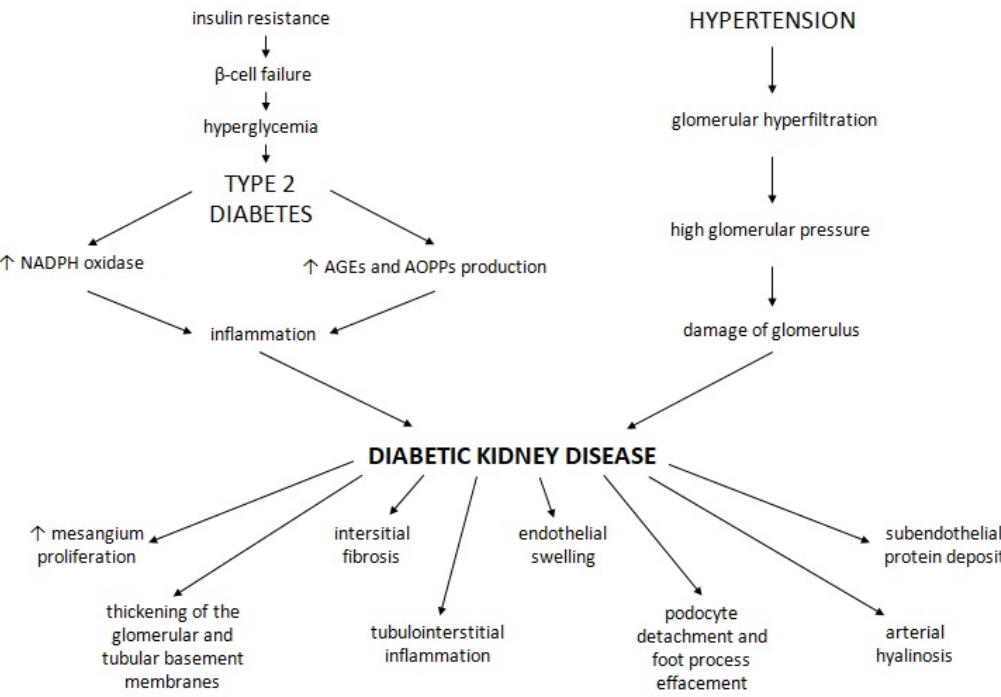
Figure 3. The pathophysiology of diabetic kidney disease. A description is given in the text above.